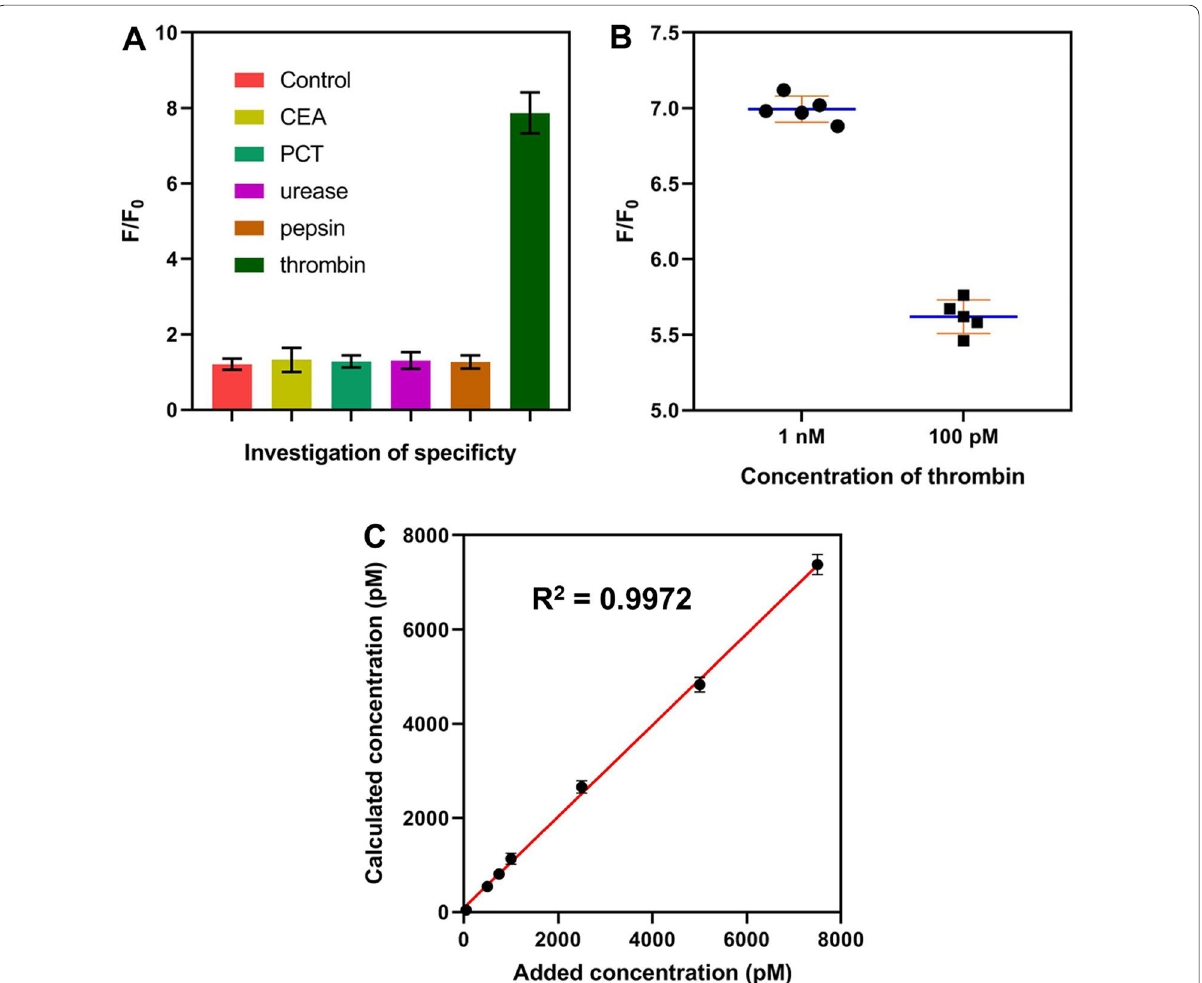
tional file 1: Table S1. The sequences were